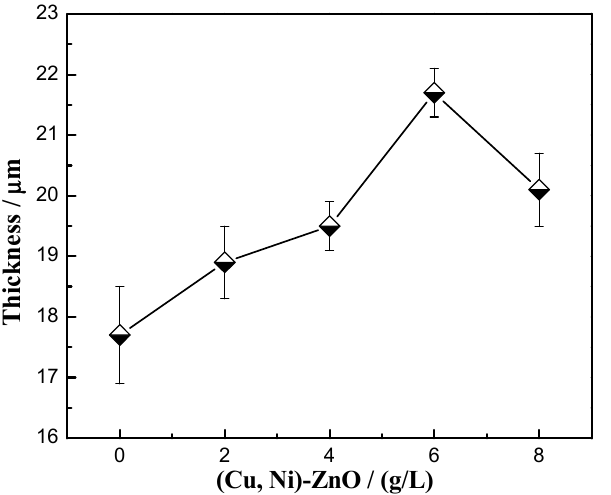
Figure 5. Thickness of Cu-Ni-ZnO nanocomposite coatings with different (Cu, Ni)-ZnO additions.